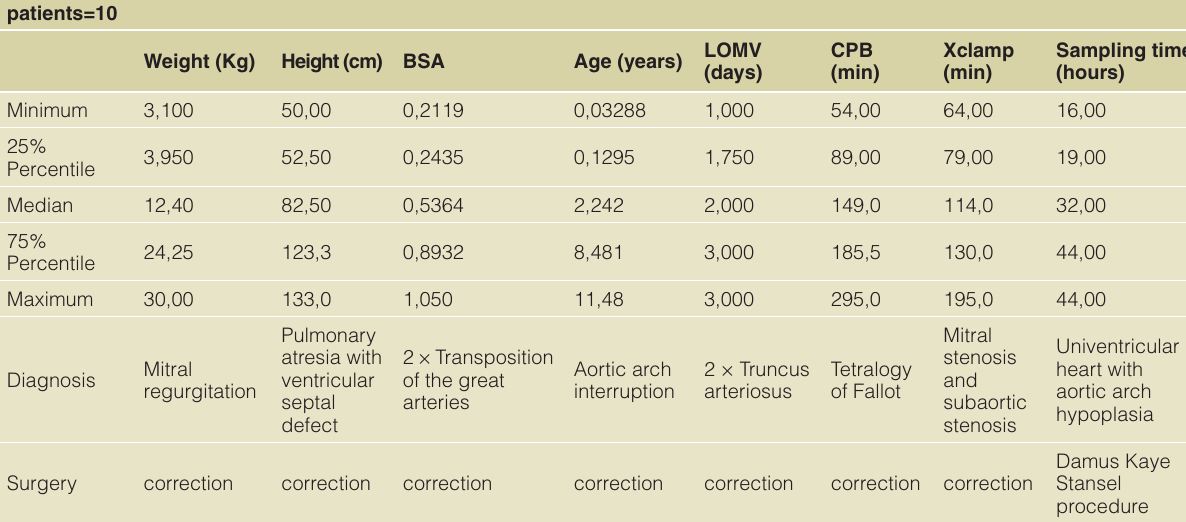
Table 1. Demographic data of enrolled patients. BSA: body surface area. LOMV: length of mechanical ventilation. CPB: cardiopulmonary bypass. Xclamp: cross clamp. Number of